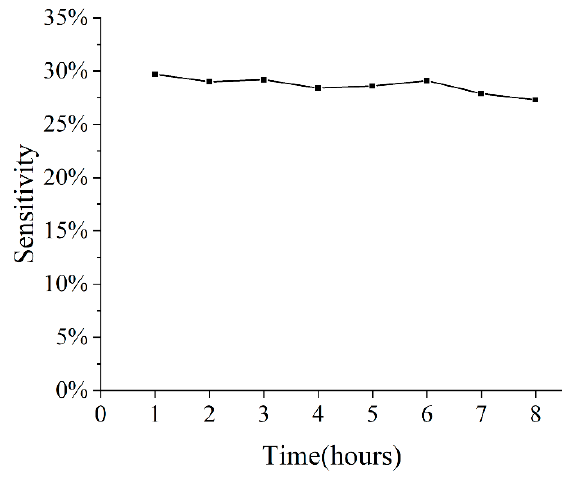
Figure 13. Sensitivity of the SnO 2 sensor device over